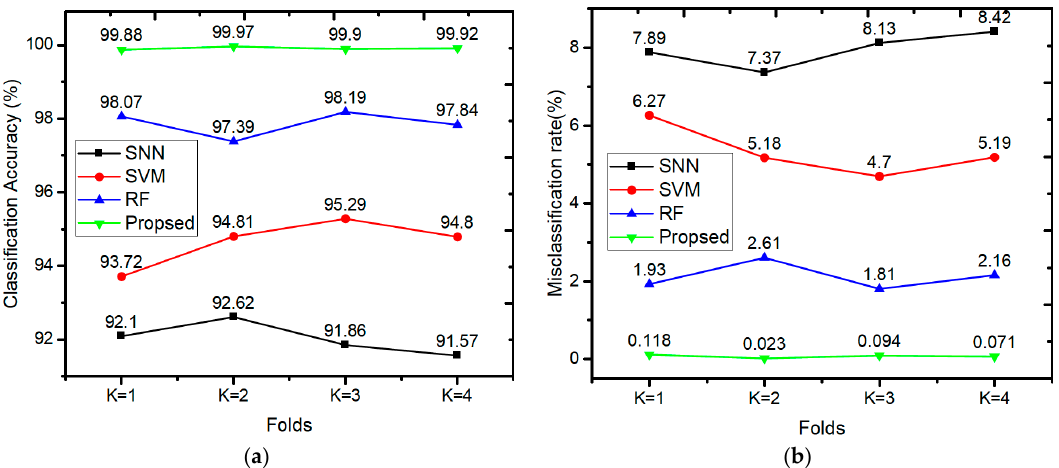
Figure 13. Performance comparison of different classification methods on each fold: ( a ) Classification accuracy on each fold; ( b ) Error (misclassification rate) on each fold.